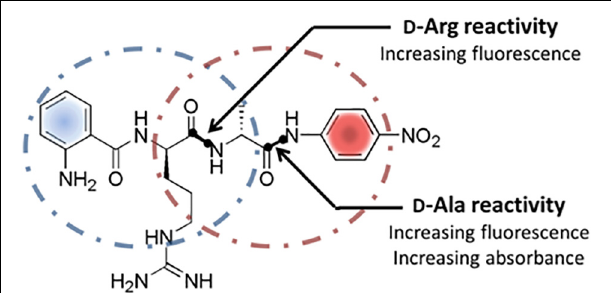
FIGURE 1 | Structure and cleavage sites of the dual screening substrate Abz- D -Arg- D -Ala- p NA. Multiple proteolytic specificities toward D -Arg and/or D -Ala can be detected via fluorescence measurements at λ ex = 320 nm/ λ em = 420 nm and simultaneous UV/ vis -spectroscopy at 405 nm. Positive fluorescence signals indicate a general cleavage activity toward D -Arg and/or D -Ala while positive UV/ vis -absorbance signals display a proteolytic specificity for D -Ala